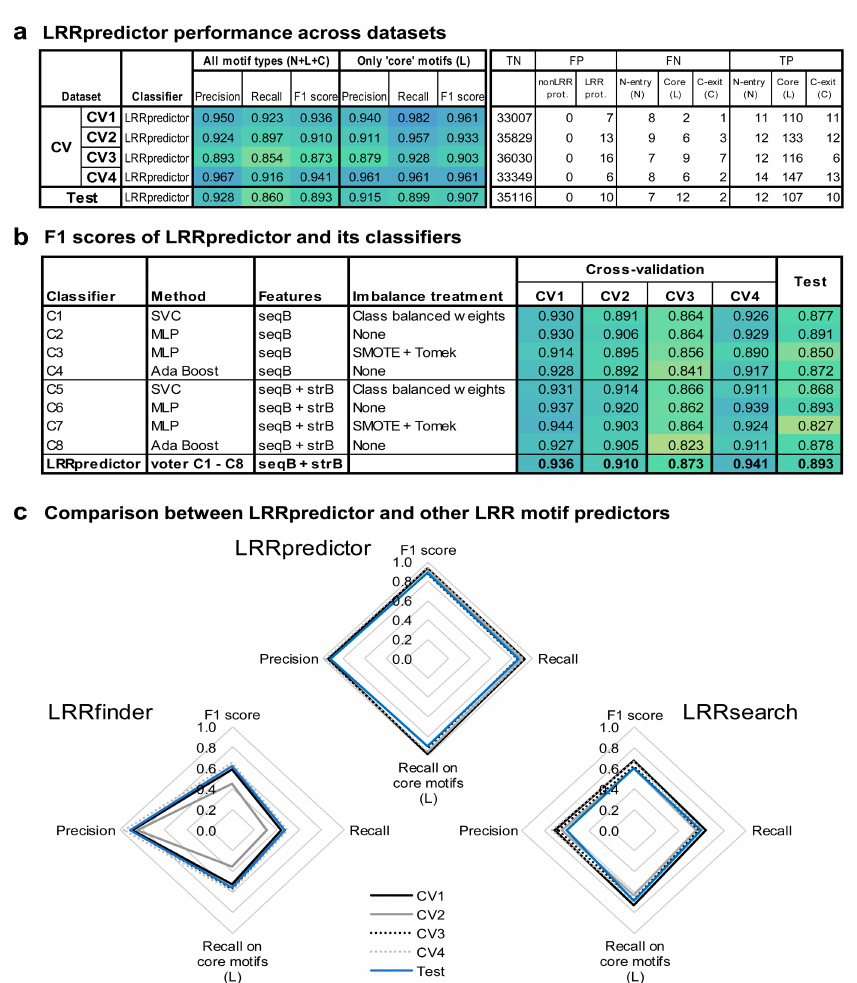
Figure 3. LRRpredictor performance analysis: ( a ) LRRpredictor performance across datasets: precision, recall, and F1 scores are shown either considering all the LRR motif types (N-entry, core, and C-exit types), either solely core motifs (L); also shown are the true negative (TN), false positive (FP), false negative (FN) and true positive (TP) counts. ( b ) F1 scores of LRRpredictor and its individual classifiers. ( c ) Comparison between LRRpredictor and other LRR motif predictors: LRRfinder [26] and LRRsearch [27] (computed on their webservers using default parameters).